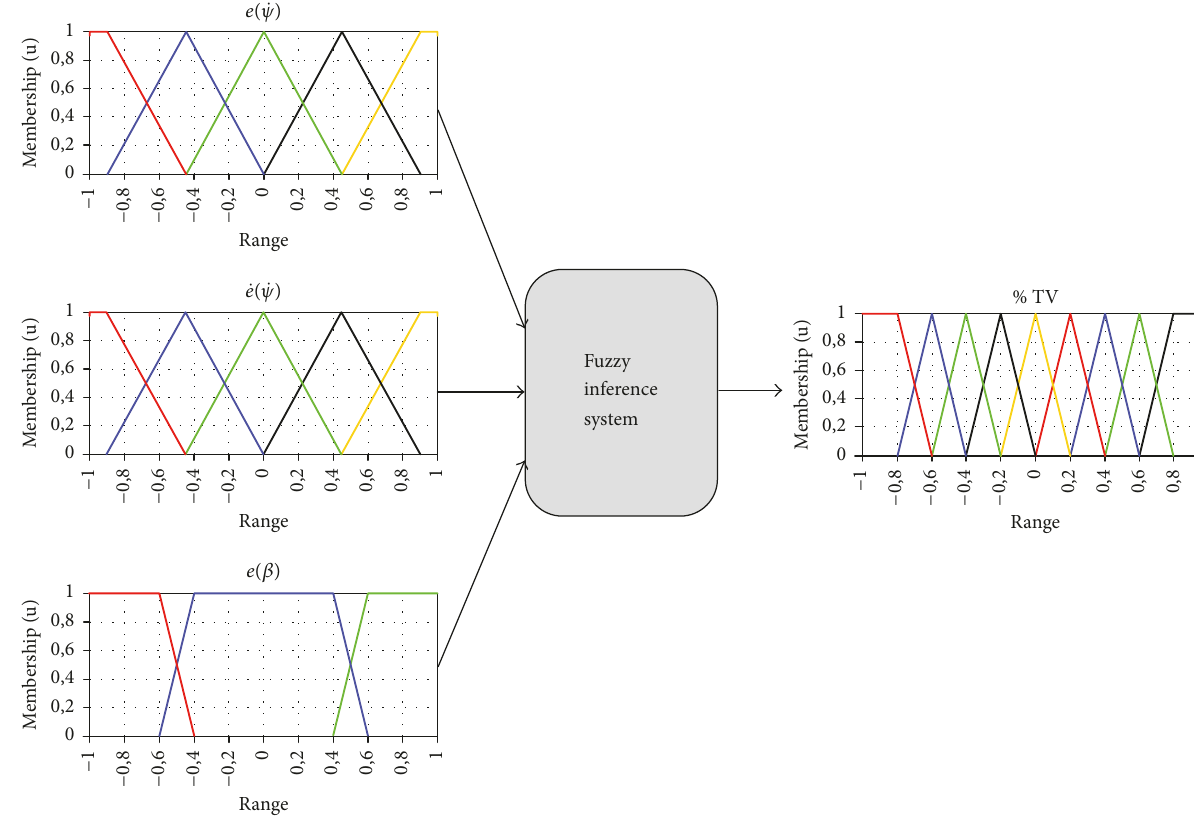
Figure 3: Fuzzy logic controller